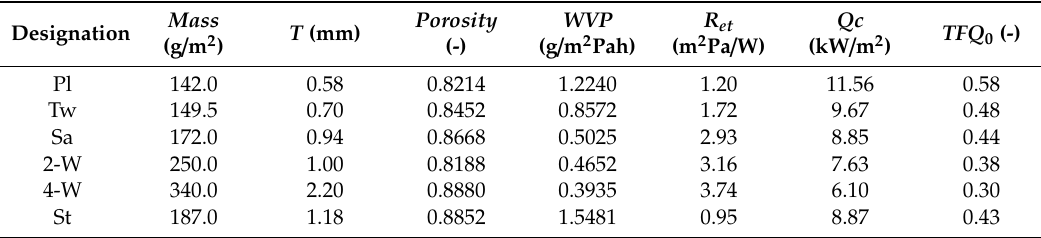
Table 5. Results of fabric samples, summary